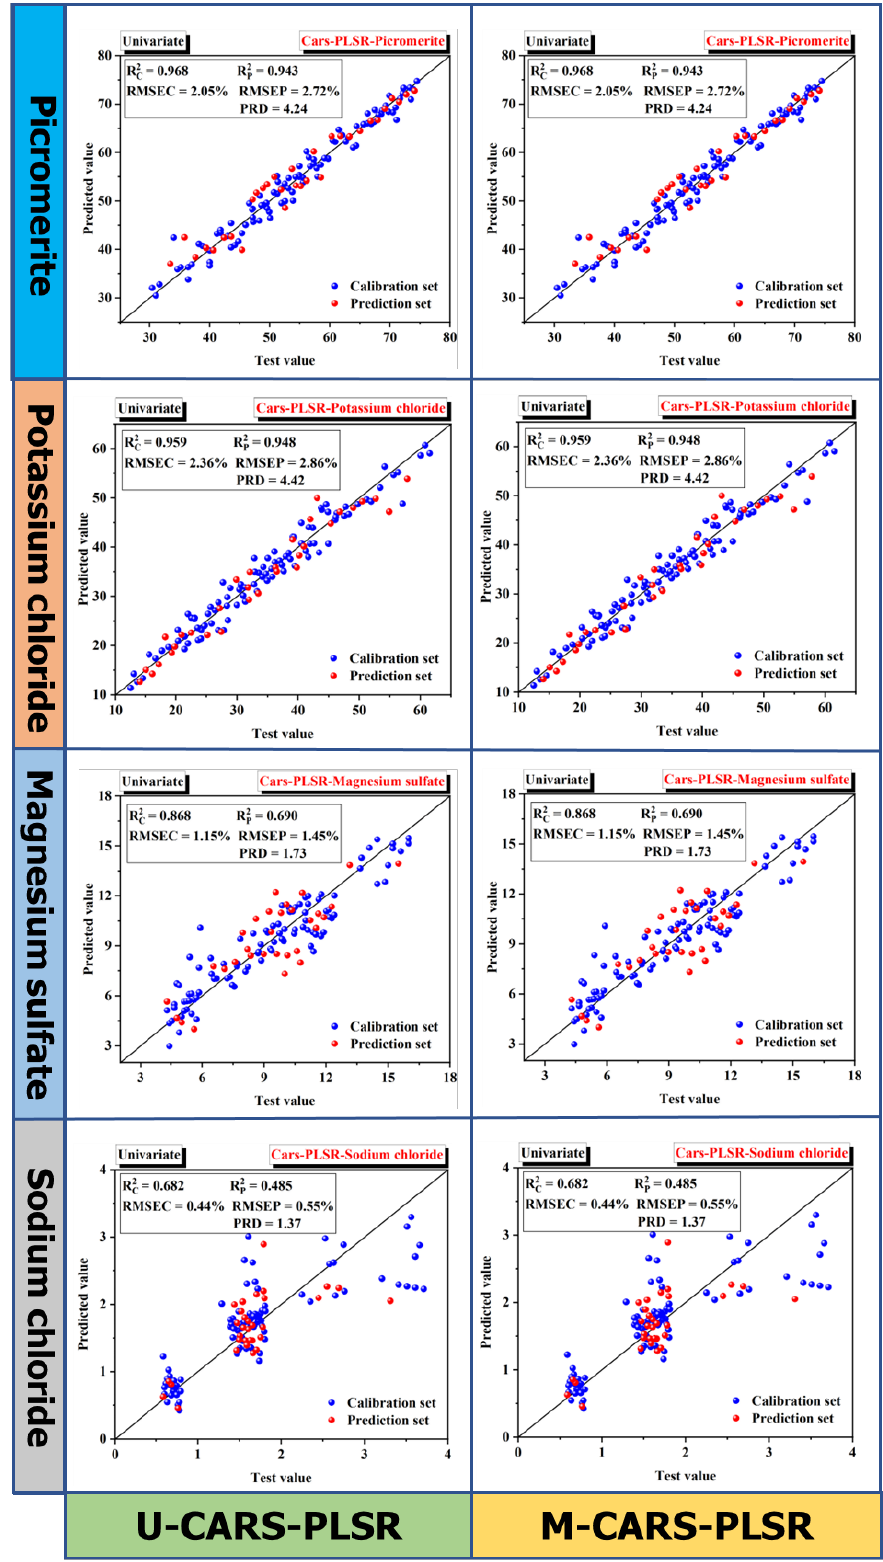
Figure 11. Prediction results of U- CARS -PLSR and M- CARS -PLSR models for MP samples. Table 7. Results of calibration and prediction sets for U-CARS-PLSR and M-CARS-PLSR models.